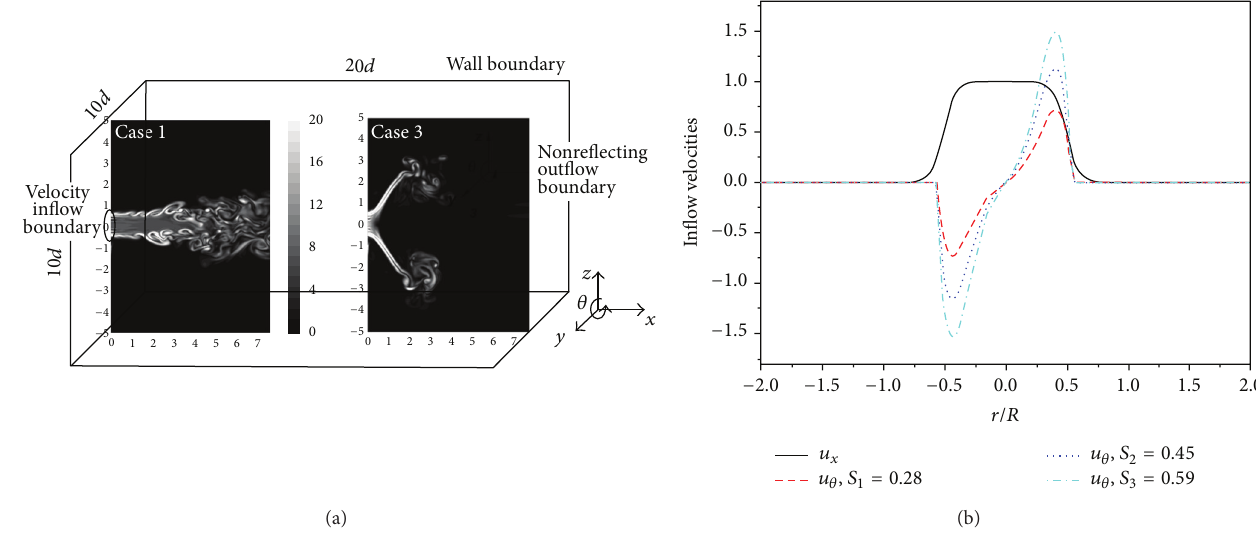
Figure 1: Sketch of simulation setup: typical vortex streets (a) and inflow velocity profiles (b).